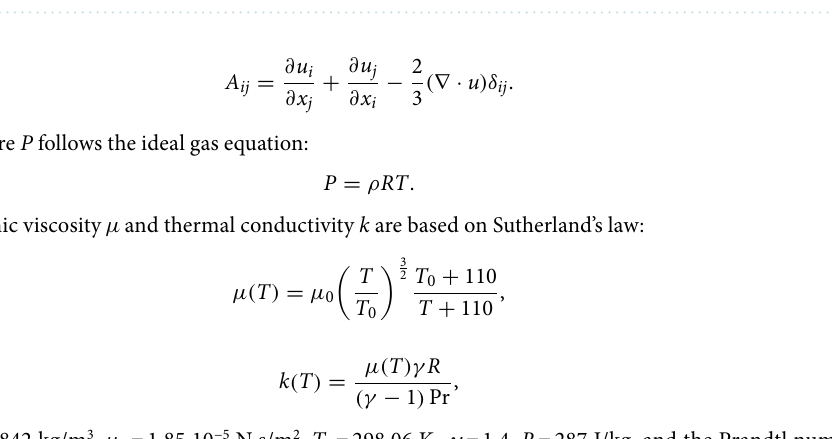
Figure 1. ( a ) Vocal tract geometry for pronouncing /s/. ( b ) Top and ( c ) side views of the vocal